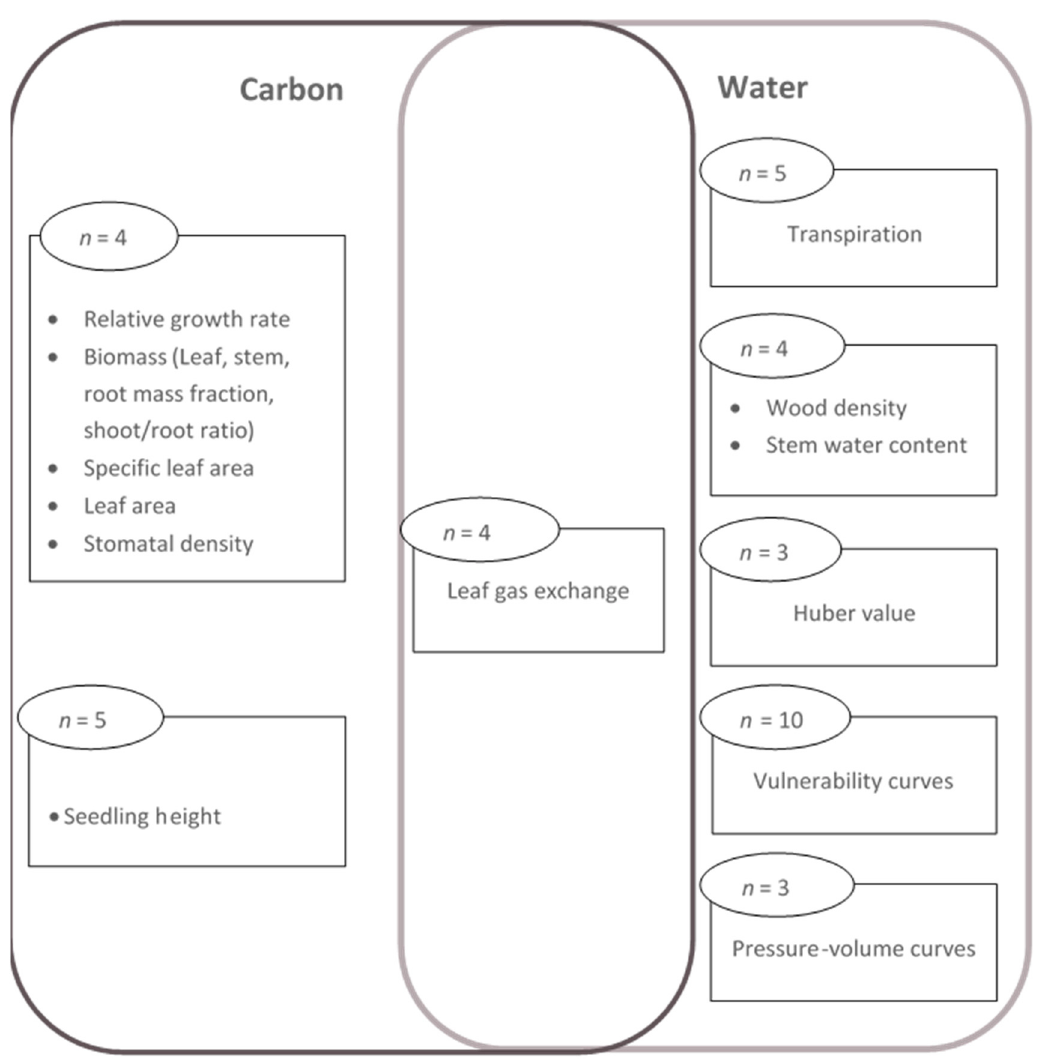
Figure 1. Overview of traits related to carbon and water management. The number of replicates used is indicated in the circles (the number of individuals considered per species for each group of traits).